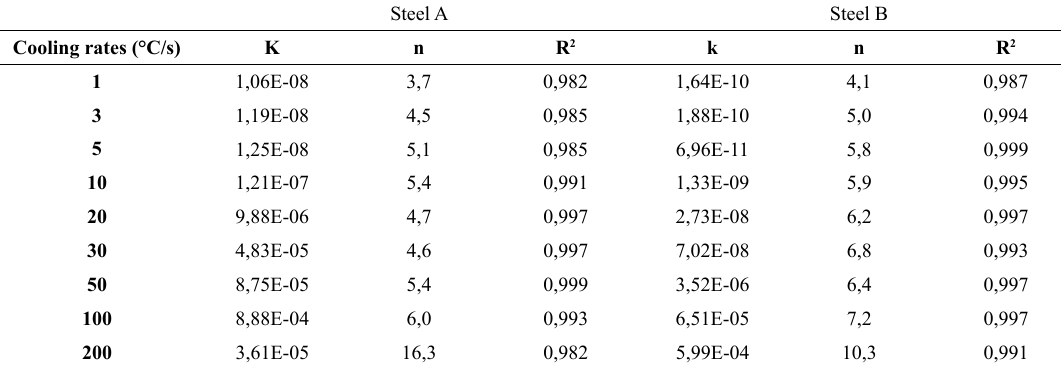
Table 2. Avrami’s equation parameters and statistical parameter R 2